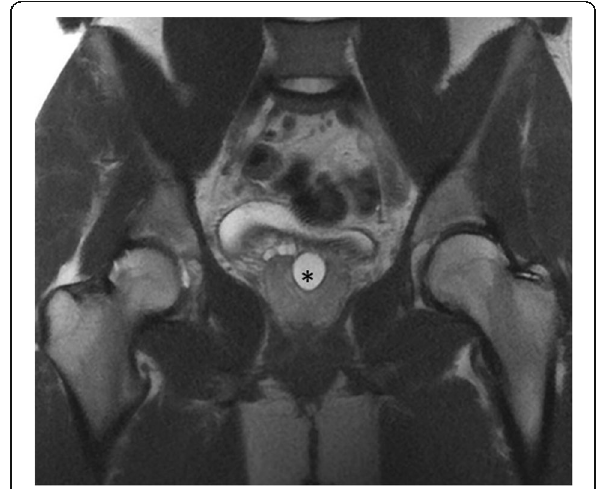
Fig. 34 A 17-year-old male patient with urinary incontinence. Coronal plane T2W MR image shows a midline prostatic cyst (asterisk) that does not extend above the prostate